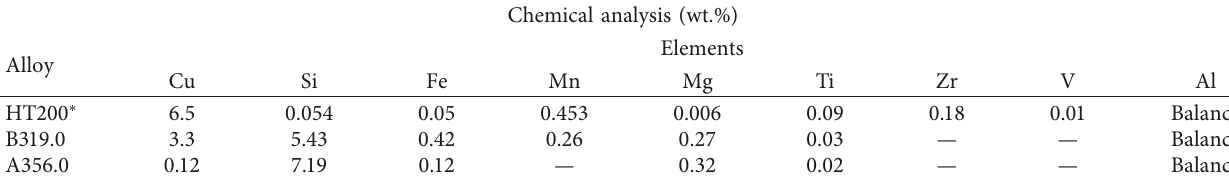
Table 1: Chemical composition of the as-received base alloys used in this study.